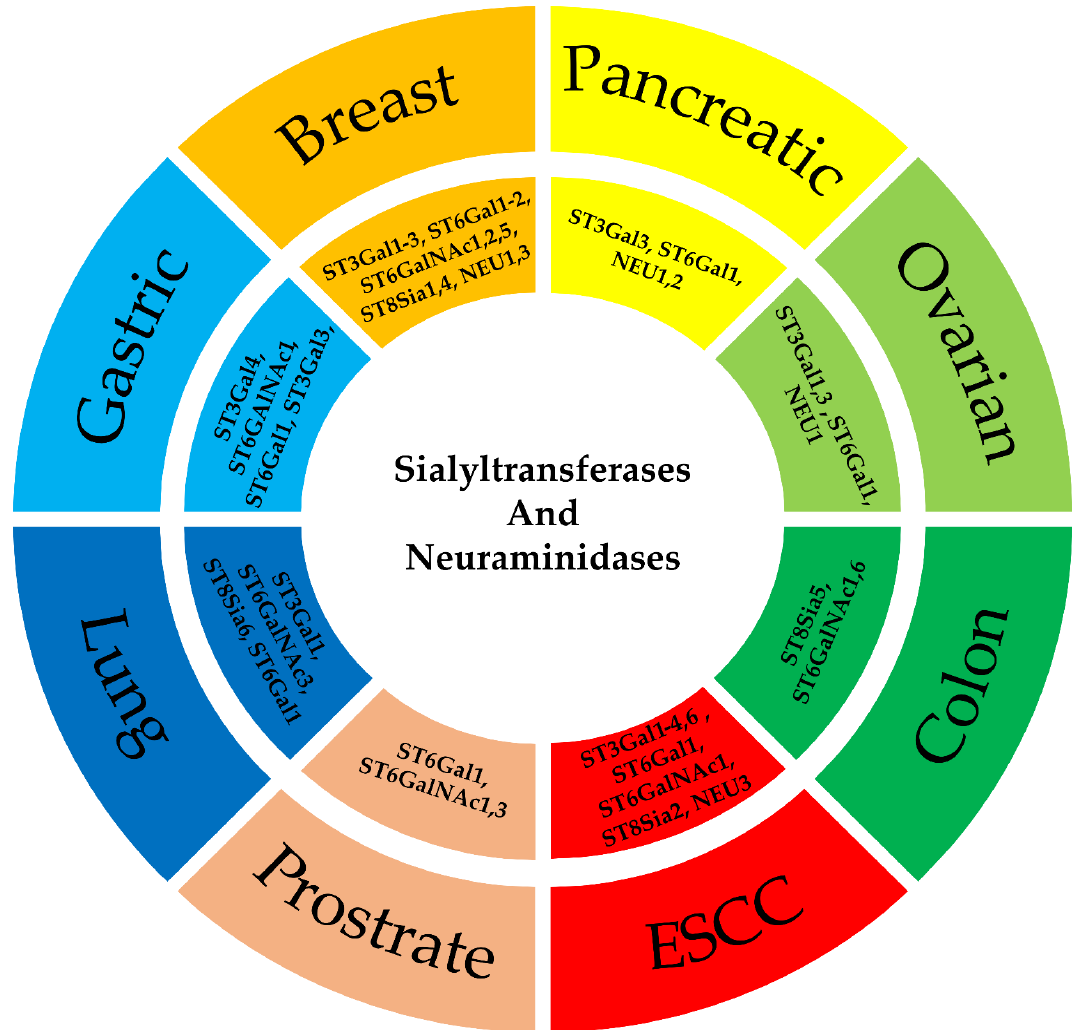
Figure 3 . Role of sialyltransferases and neuraminidases in various cancer. Figure 3. Role of sialyltransferases and neuraminidases in various